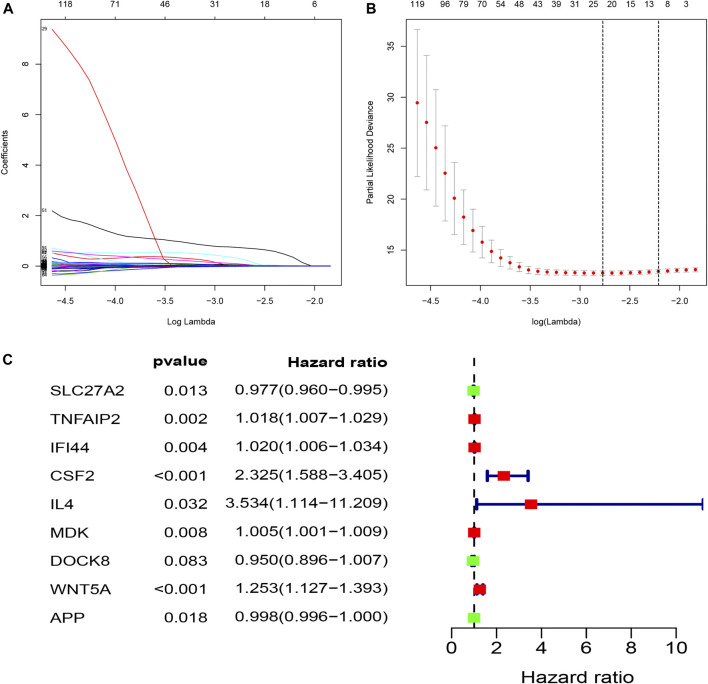
Construction of a prognostic model (riskScore) by means of LASSO and adjusted Cox regression analysis; (A,B) LASSO coefficients profiles of the prognostic apoptosis-related genes; The partial likelihood deviance plot presented the minimum number corresponds to the covariates. utilized for adjusted Cox regression analysis; (C) The forest plot of differently expressed apoptosis-related genes were identified to be significantly related to OS of ccRCC patients by adjusted Cox regression analysis. Green points represent negative correlations, whereas red points represent positive correlations.